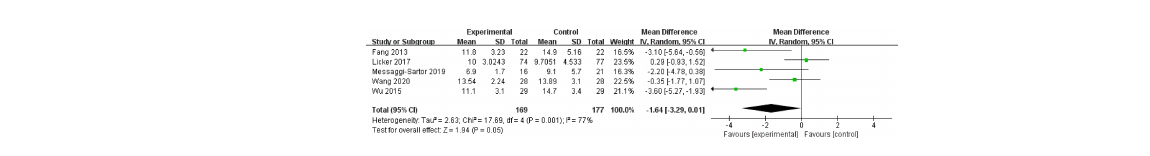
FIGURE 7 Meta-analysis of the effect of HIIT on length of hospitalization (days) among lung cancer patients.